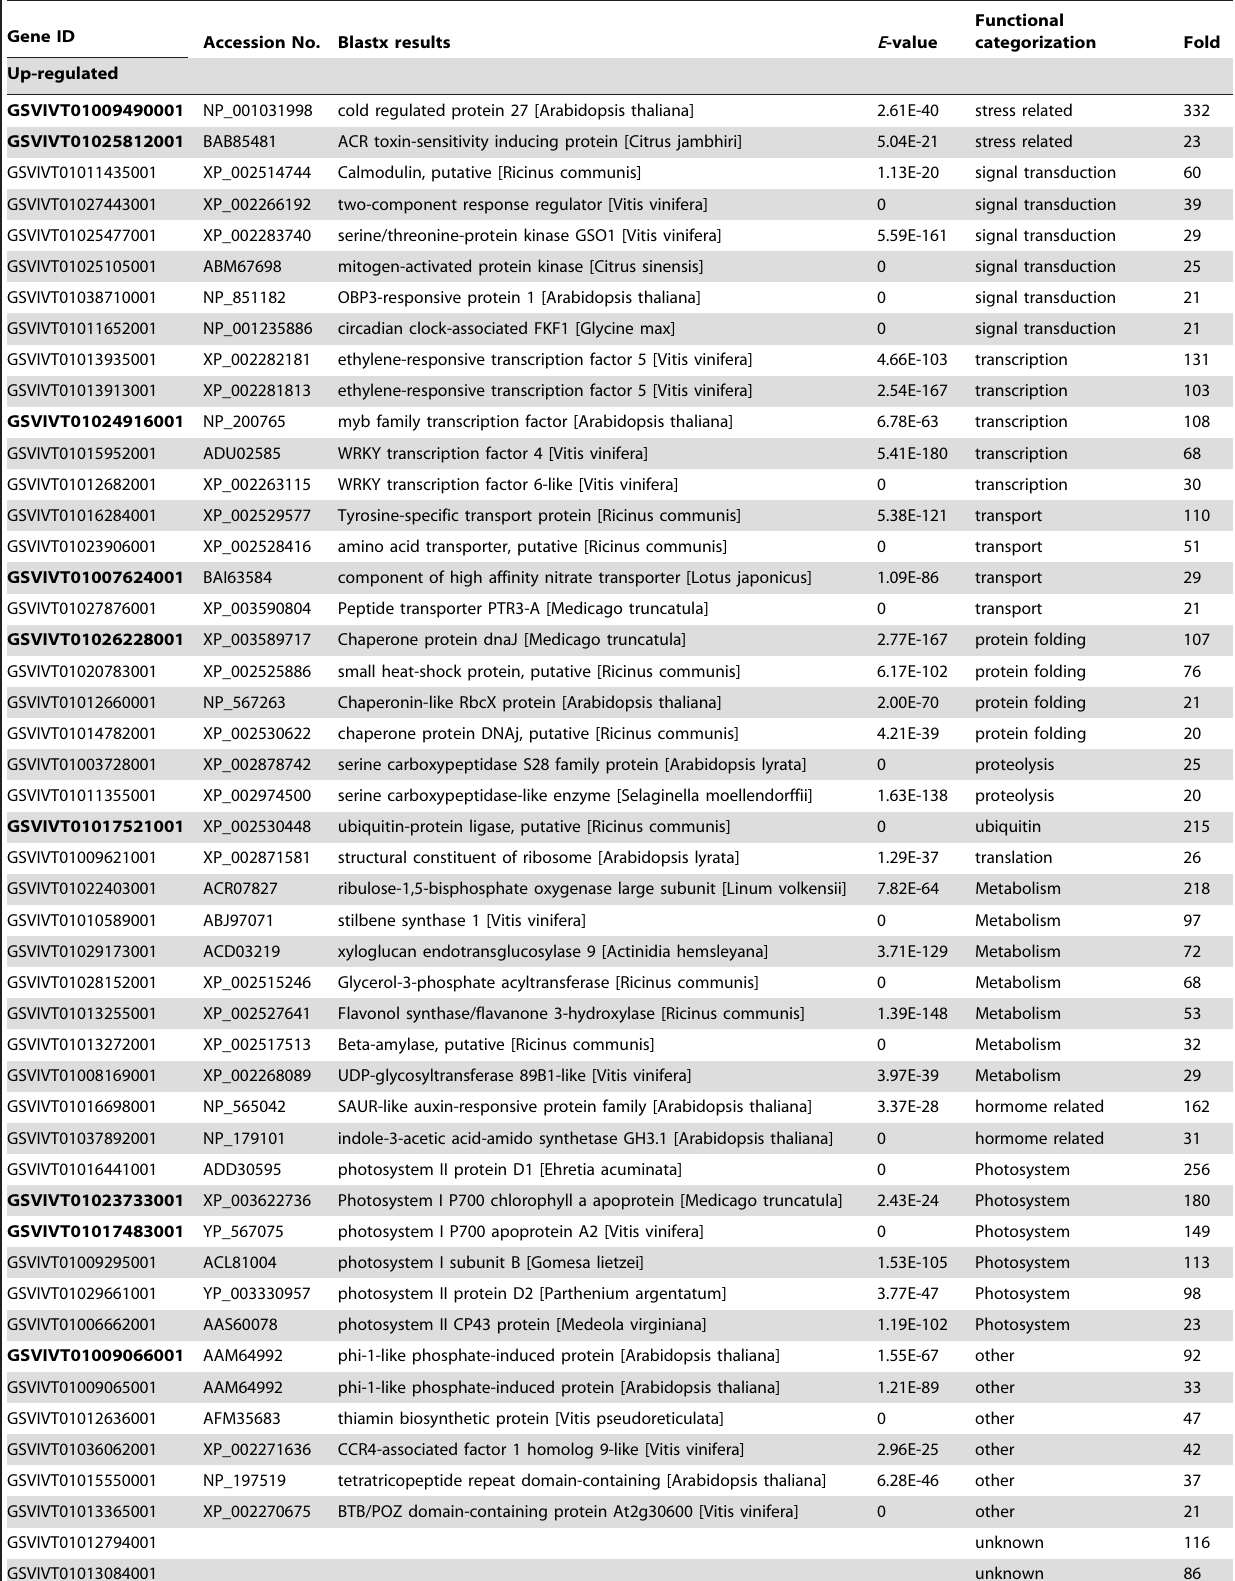
Table 4. List of DEGs changed for 20 fold and more in Vitis amurensis .